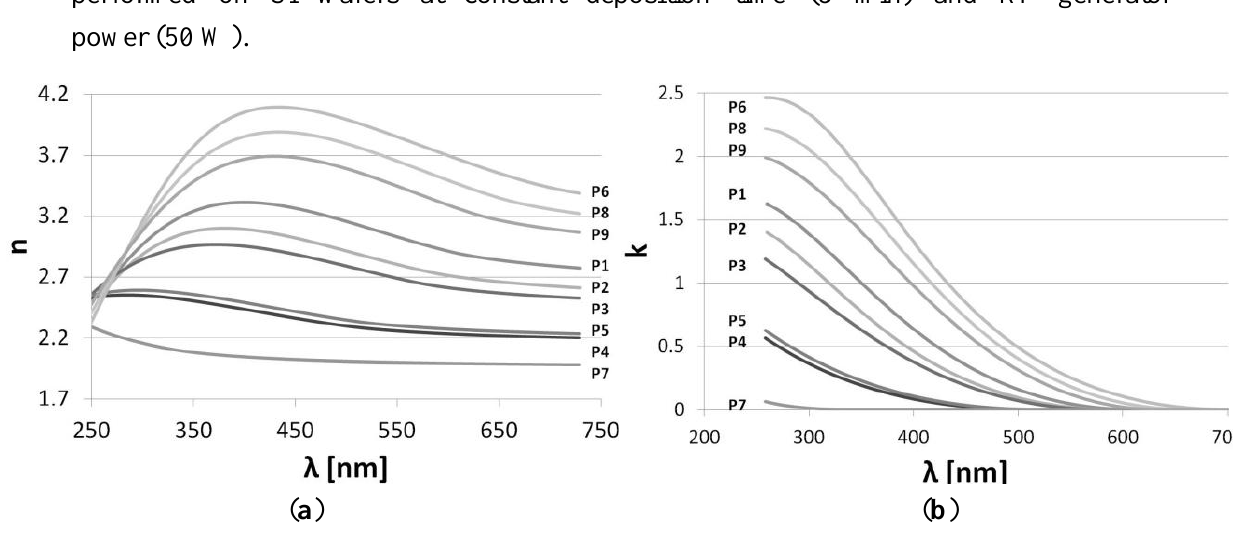
and f , and p SiH4 NH3 films. The deposition was x